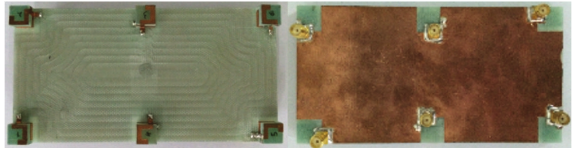
Figure 11: Photograph of the fabricated six-element MIMO system.